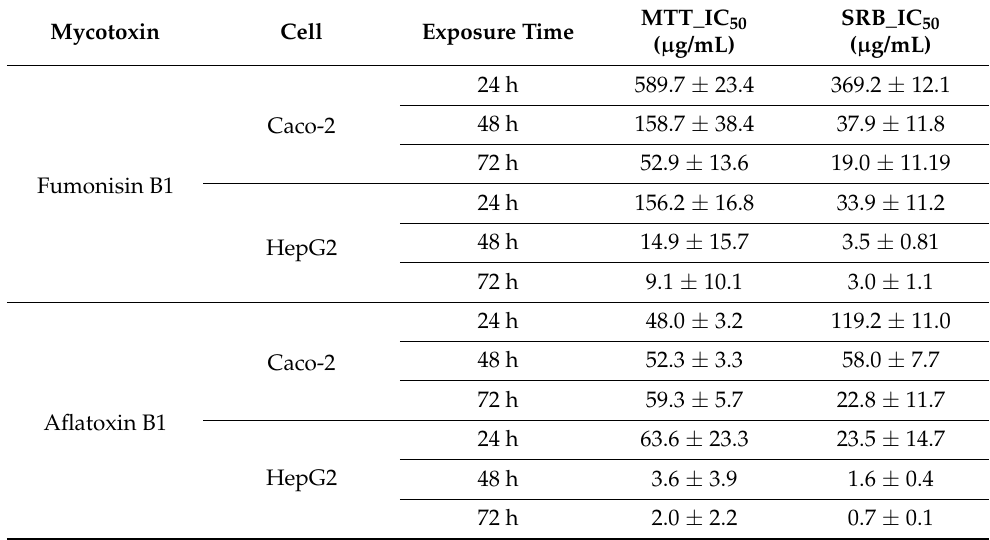
Table 1. IC 50 values ( ± SD) of FB1 and AFB1 in Caco-2 and HepG2 cells after 24 h, 48 h and 72 h of